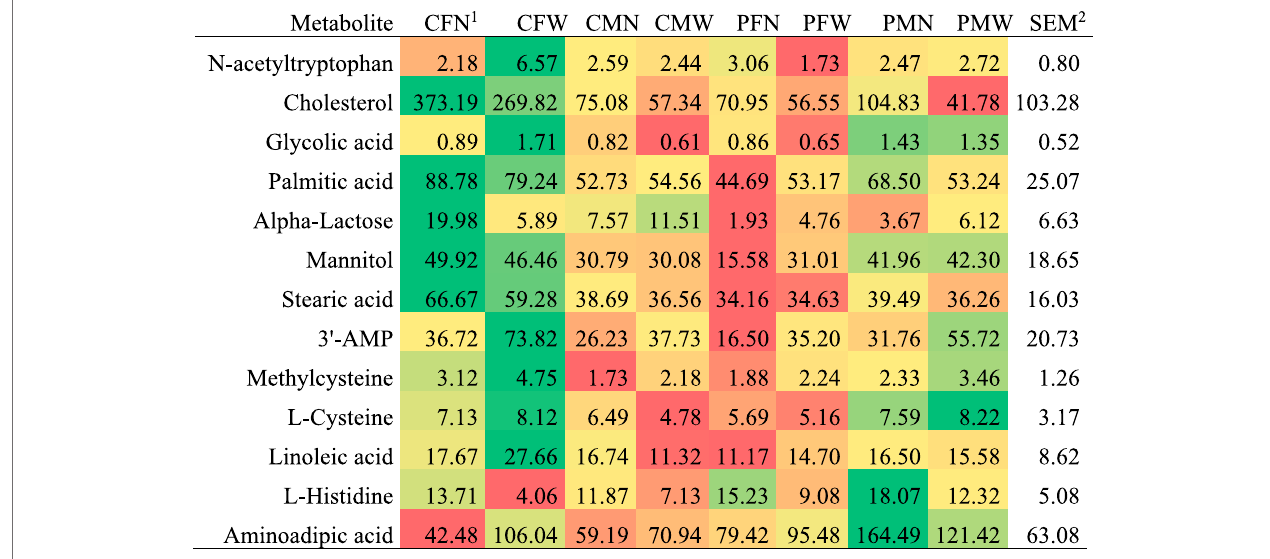
FIGURE 2 | Abundance pro fi le across weaning, maternal immune activation, and sex groups for metabolites that presented maternal immune activation effect alone or interacting with other factors.